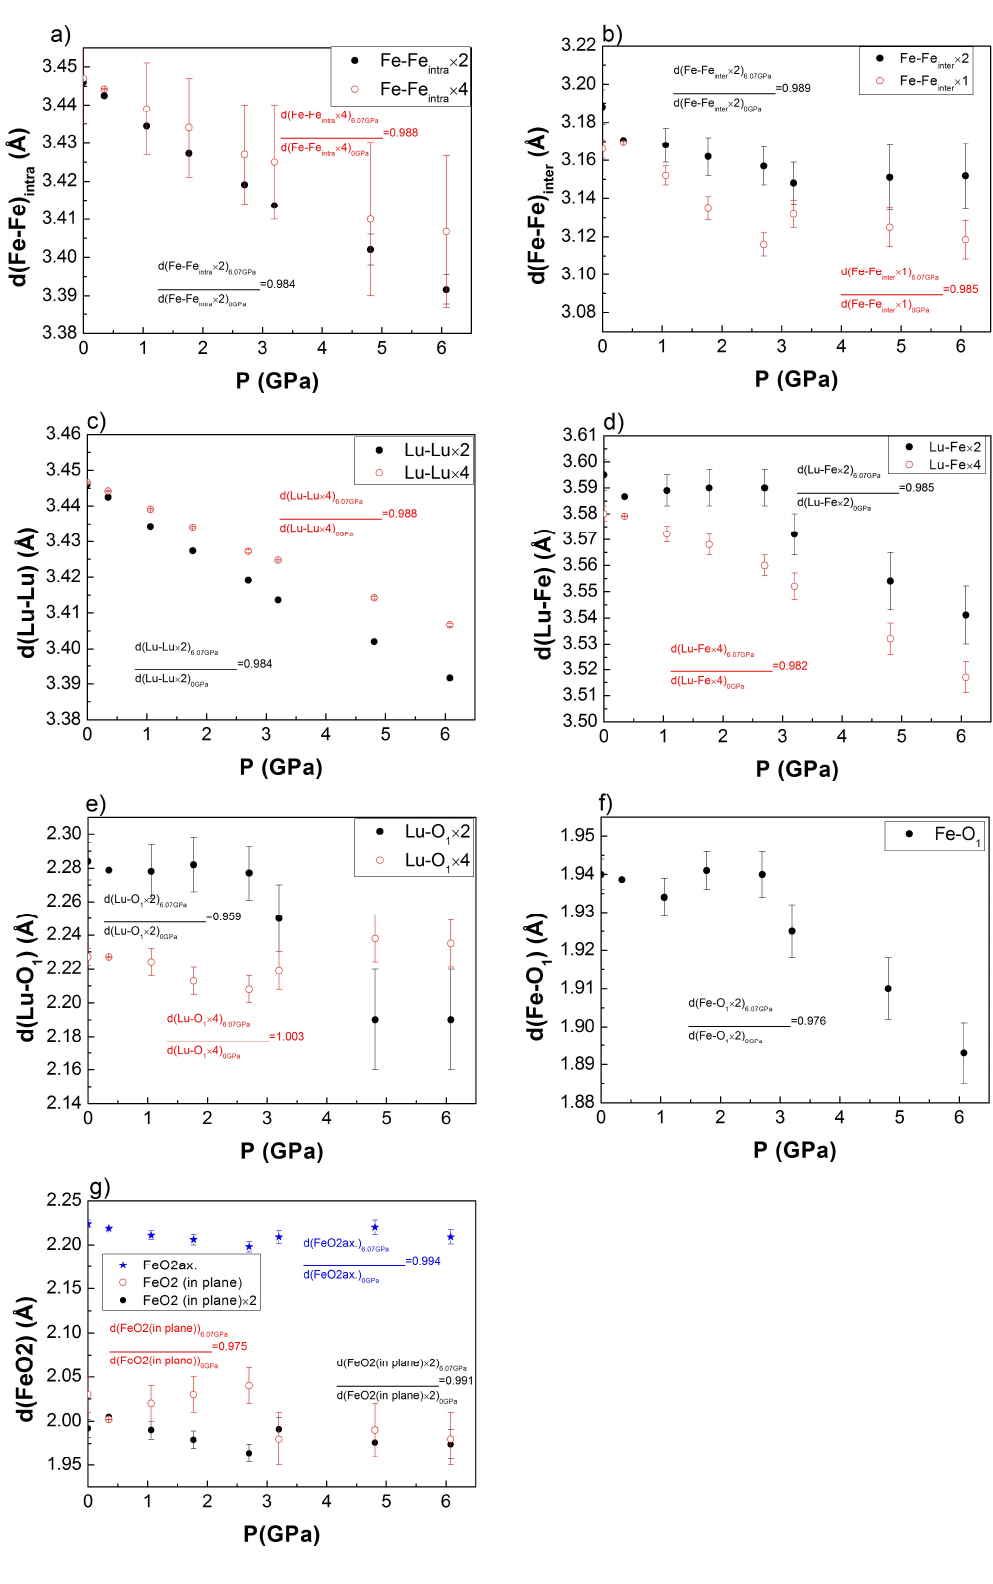
Figure 9. Pressure dependence of the ( a ) Fe-Fe intra ; ( b ) Fe-Fe inter ; ( c ) Lu-Lu; ( d ) Lu-Fe; ( e ) Lu-O 1 ; ( f ) Fe-O 1 ; ( g ) Fe-O 2 distances based on Rietveld refinements using ND data of the M1 phase. For each distance, the different relative compressibilities are calculated.